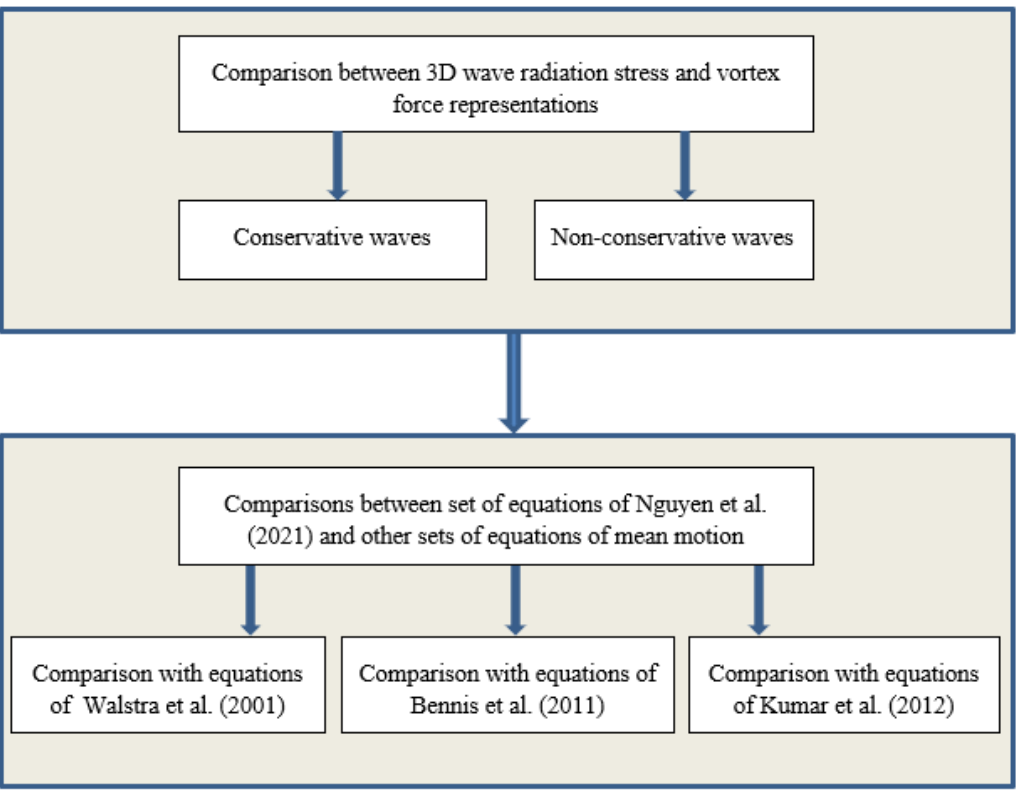
Figure 1. Flowchart of the methodology of this study.